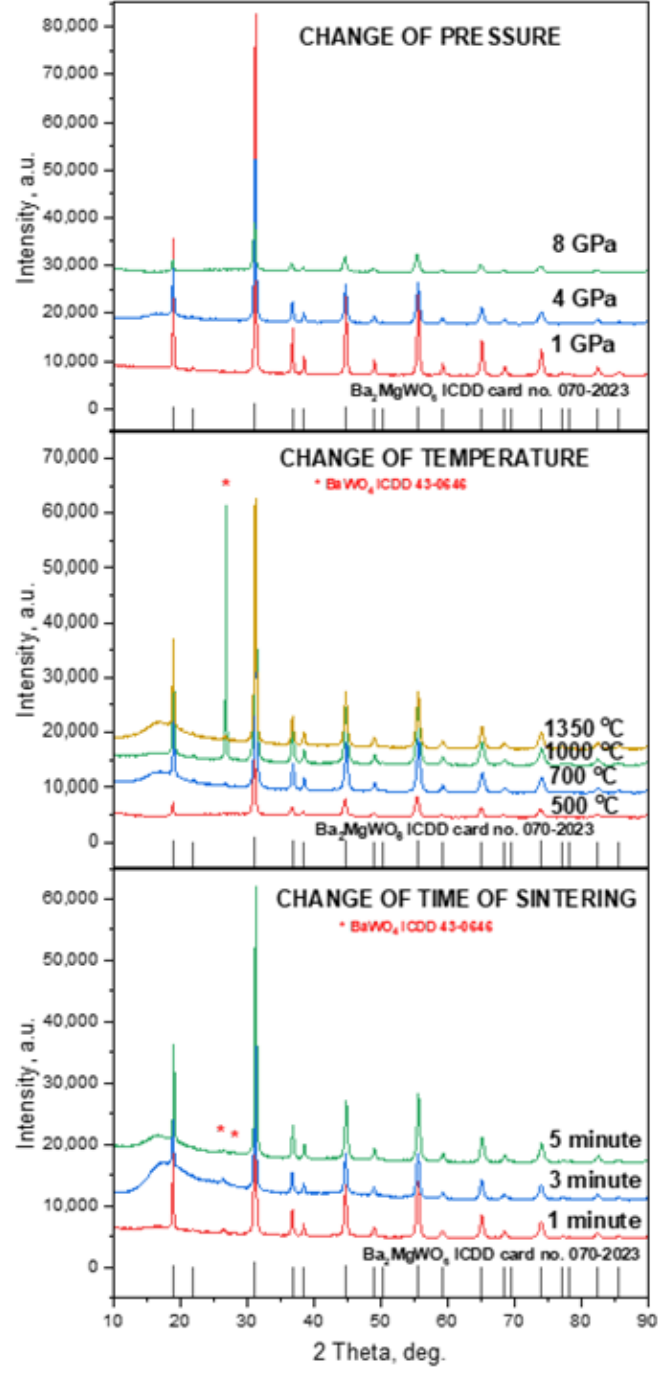
Figure 3. XRD patterns for BMW:Eu-CP, BMW:Eu-CT, and BMW:Eu-CTS, from up to down, respec- tively.